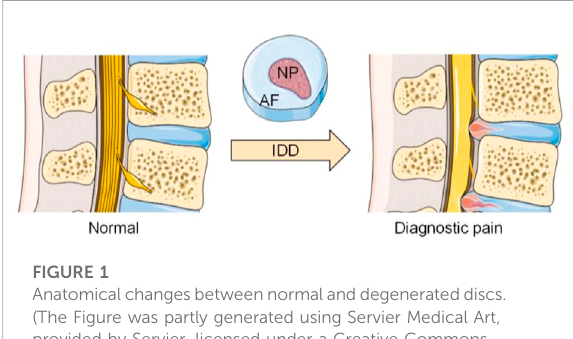
FIGURE 1 Anatomicalchangesbetweennormal and